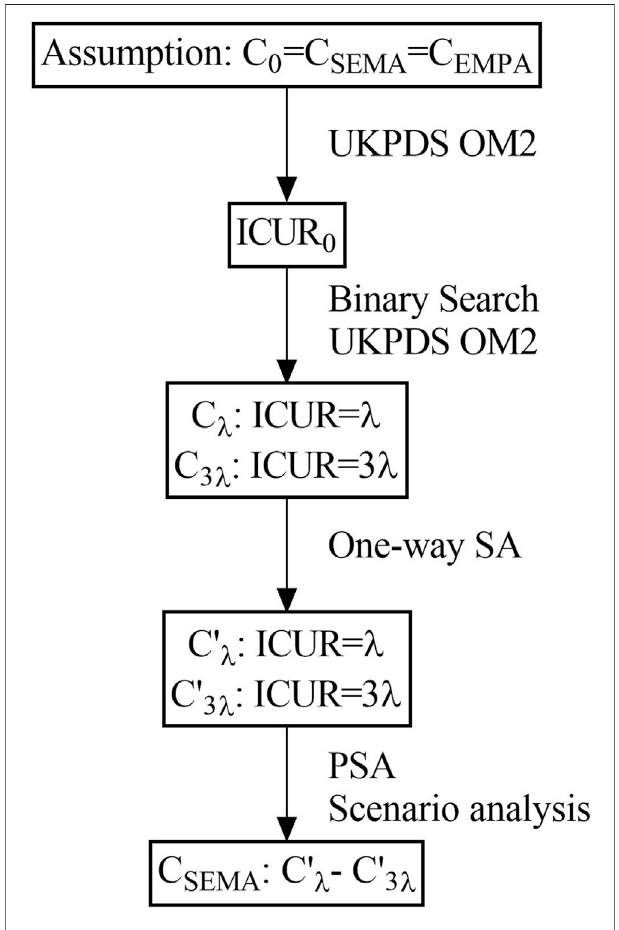
FIGURE 1 | Method fl ow chart.